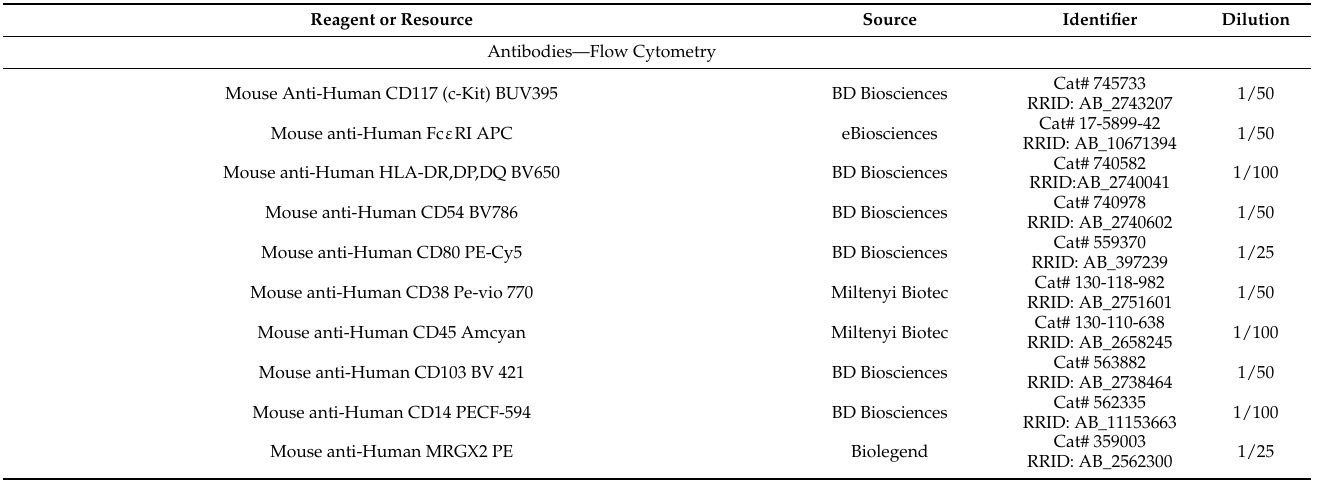
Table 2. Key Resources